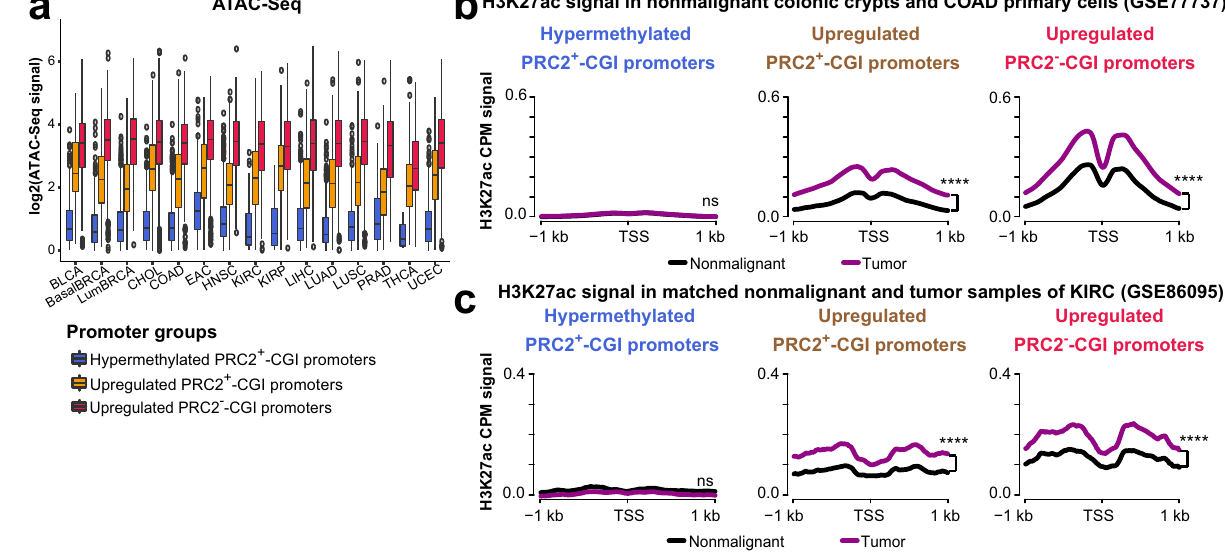
Fig. 2 Upregulated PRC2 + -CGI genes have increased promoter H3K27ac levels and accessible chromatin in tumors. a TCGA ATAC-Seq signals for each of the three CGI promoter classes in each cancer type. Box plots indicate the median (middle line), 25th, 75th percentile (box) and 5th and 95th percentile (whiskers); the promoter number ( n ) of each CGI class in each cancer type is listed in Supplementary Table 2. b Aggregation plots of averaged nonmalignant and primary colon cancer cells H3K27ac ChIP-Seq signals (GSE77737) for each of the three CGI promoter classes from COAD (see Supplementary Fig. 5 for details). c Similar line plots generated using H3K27ac ChIP-Seq signal from matched nonmalignant and tumor pairs of KIRC (GSE86095, see Supplementary Fig. 5 for details). p -values between two groups in panel b , c were determined by a one-sided t -test. p < 0.0001****; p > 0.05, ns. The exact p -values are shown in Supplementary Data